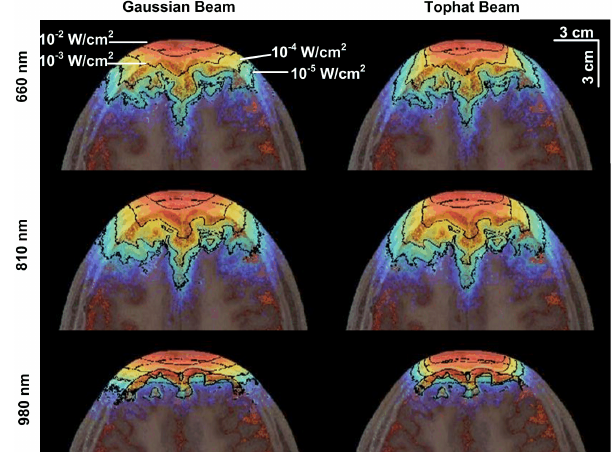
Fig. 2. The LLLT °uence distribution respective to Gaussian and Tophat (°at) beams at di®erent wavelengths.